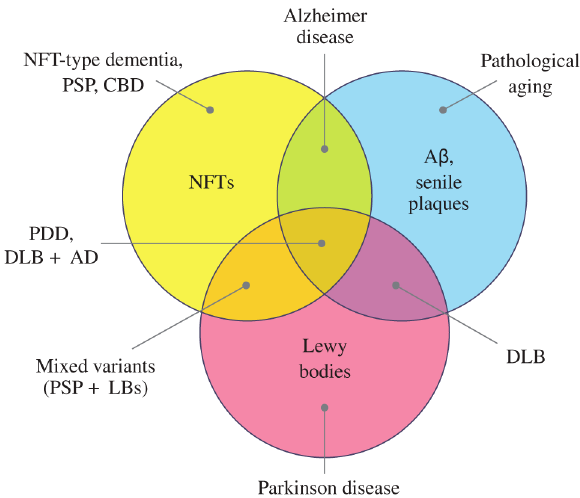
FIGURE 2: Morphologic interrelations of synucleinopathies, tauopathies, and amyloidopathies. NFTs: neu- rofibrillary tangles; PSP: progressive supranuclear palsy; CBD: corticofrontal degeneration; PDD: Parkinson disease dementia; DLB: dementia with Lewy bodies; AD: Alzheimer disease; LBs: Lewy